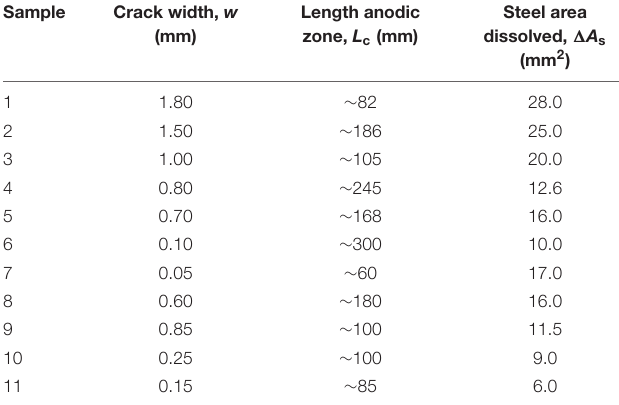
TABLE 2 | Experimental crack width values due to corrosion, calculated using data of the literature (Vidal et al., 2004). Sample